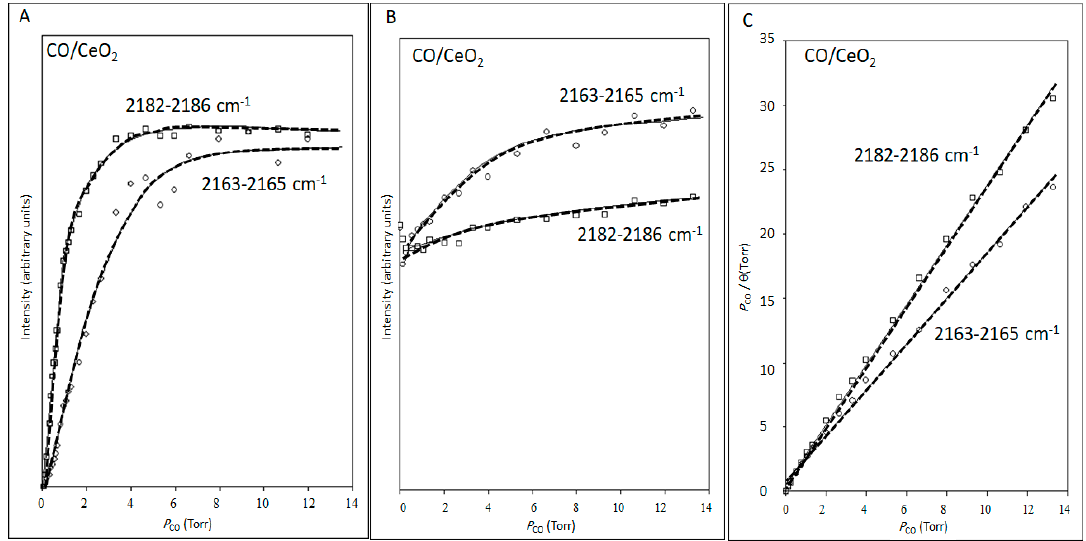
Figure 1. ( A ) Fourier Transform Infra Red (FT-IR) spectra of CO adsorbed on CeO 2 at 90 K. Indicated pressures are those of CO (upon exposure at the indicated pressure for 1 min each), spectra are collected at ~10 − 4 Torr. ( B ) and ( C ) High resolution transmission electron microscopy (HRTEM) of the CeO 2 particles on which the surface termination is indicated.